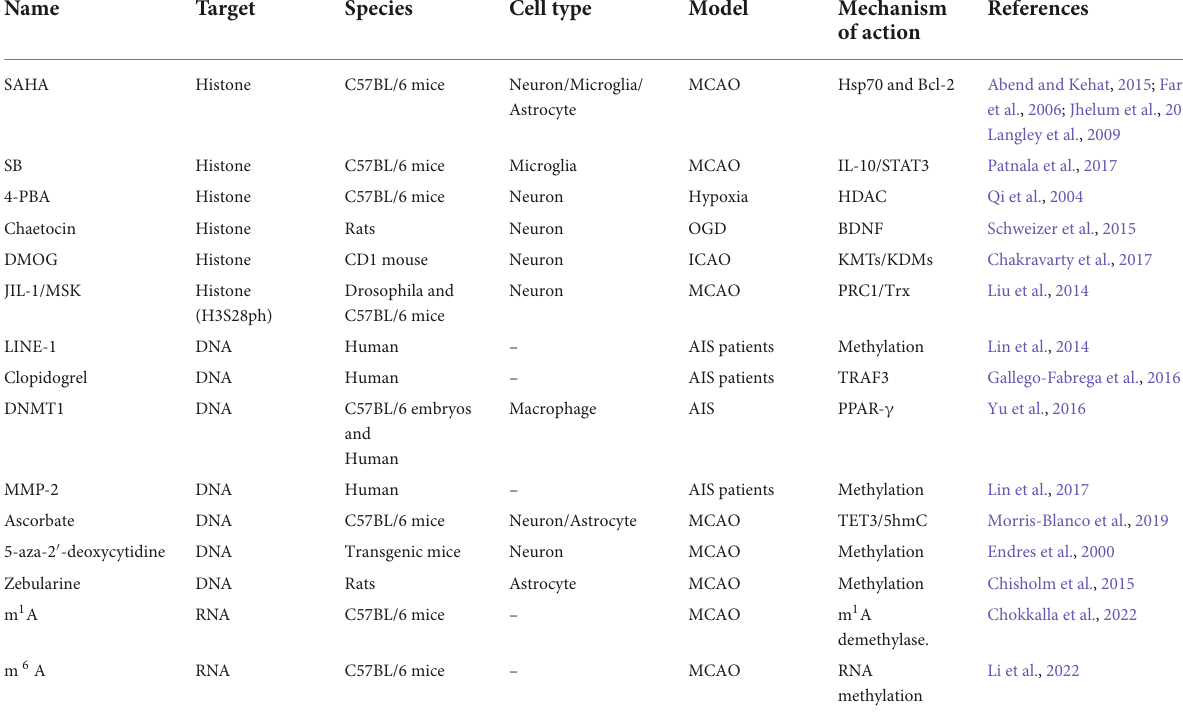
TABLE 1 Potential molecules and their targets on epigenetics in ischemic